Question: Which kind of chart has been used to present this data?
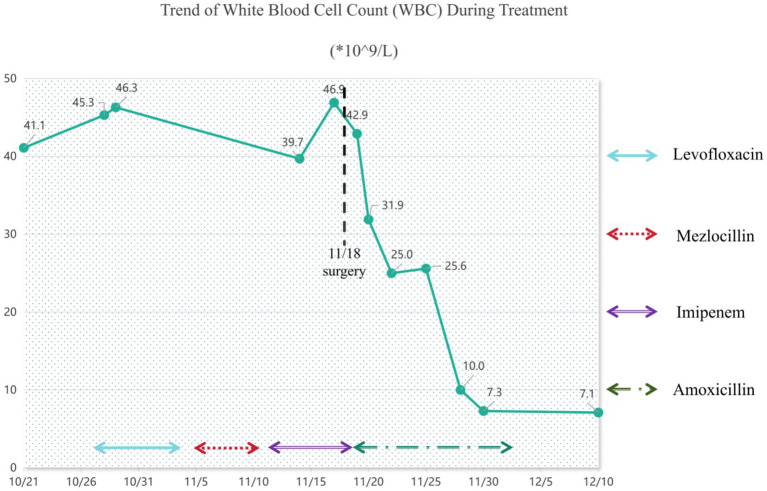
Answer: line